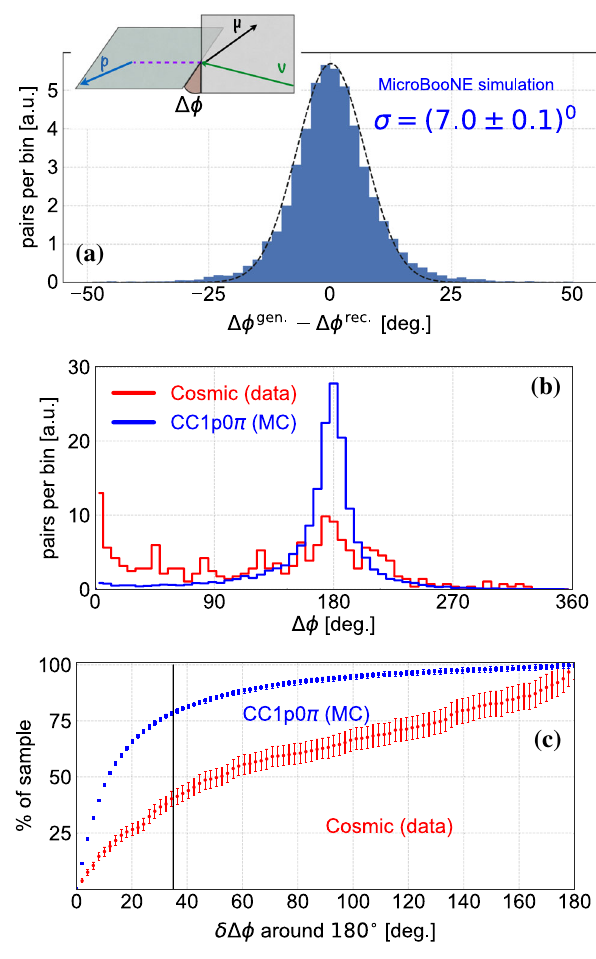
Fig. 9 a Thedifferencebetweenthereconstructedandgenerated(truth level) Δφ for CC1 p 0 π events in MicroBooNE simulation. A fit for a Gaussian distribution function around the peak is shown in the figure, as well as the width σ of the best-fit result. The illustration in the insert showsthedefinitionoftheangle. b Thedistributionsofthereconstructed Δφ between the candidate μ and p candidates after all previous criteria were applied. c The effect of a symmetric selection around Δφ = 180 ◦ as a function of the selection